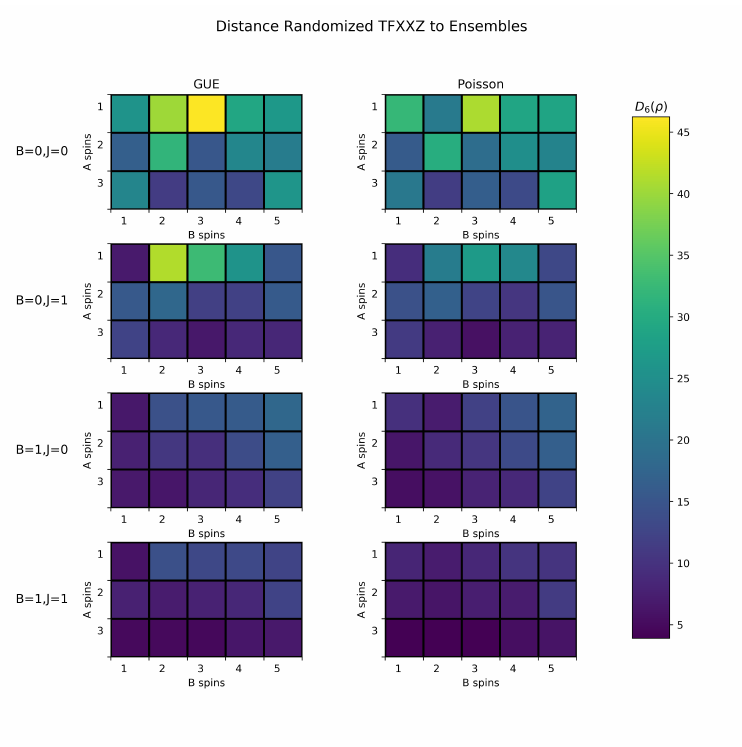
Figure 25: Left: Normalized distance of dynamics of XXZ Model (see equation 44) to analytical GUE. Right: to analytical Poisson.